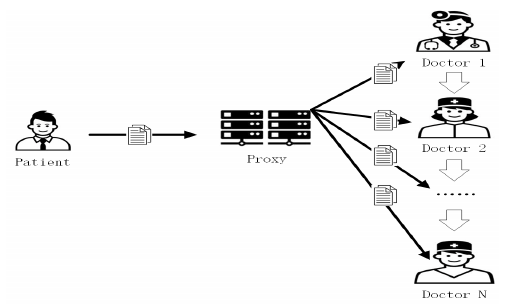
Figure 1. Electronic Health Records Sharing with Patient’s Preferred Doctors.